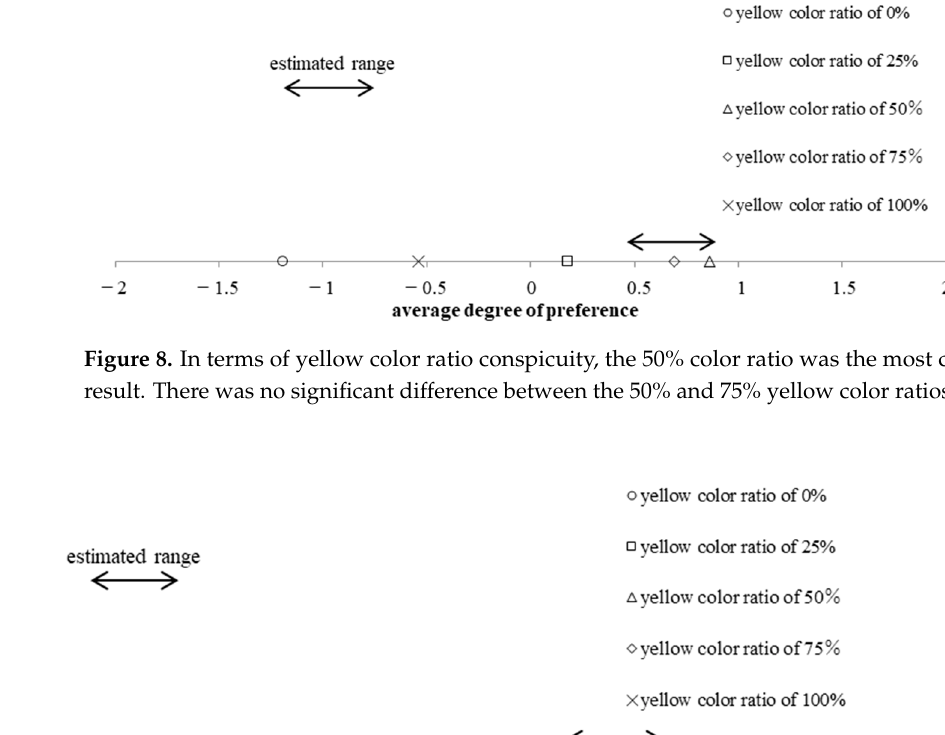
Figure 9. In terms of yellow color ratio brightness perception, the color ratio of 100% was the brightest result. There was no significant difference between the 100% and 75% yellow color ratios.